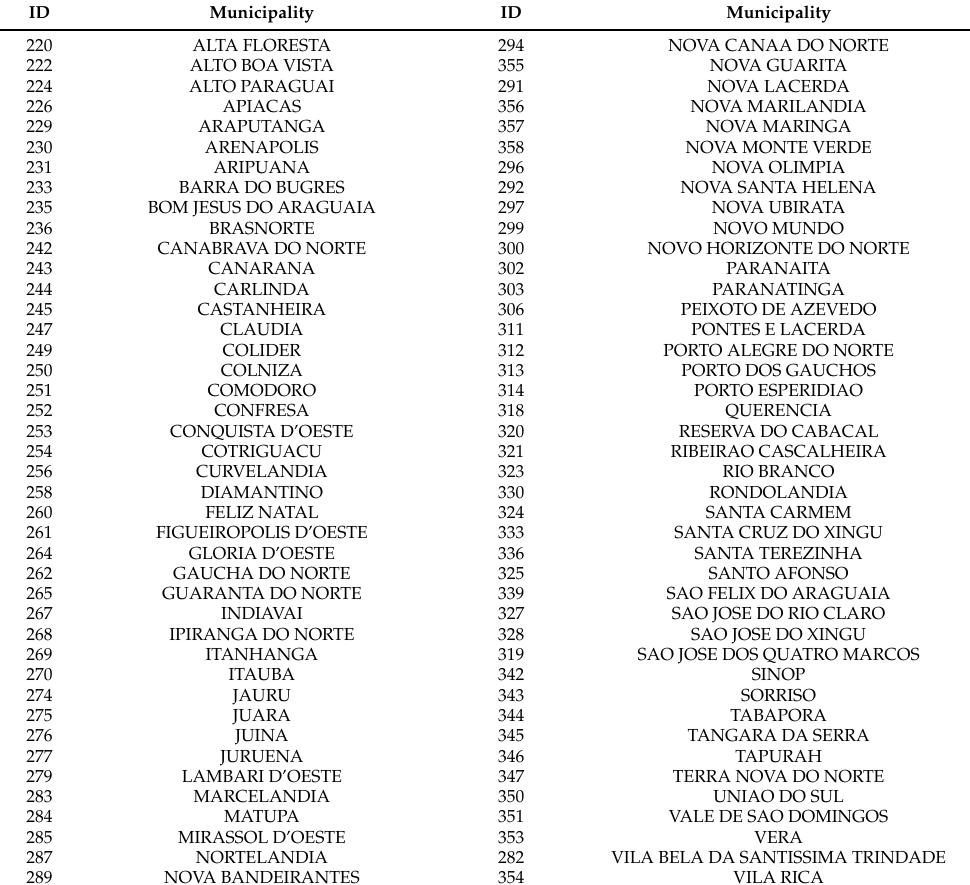
Table A1. List of Municipalities in Study